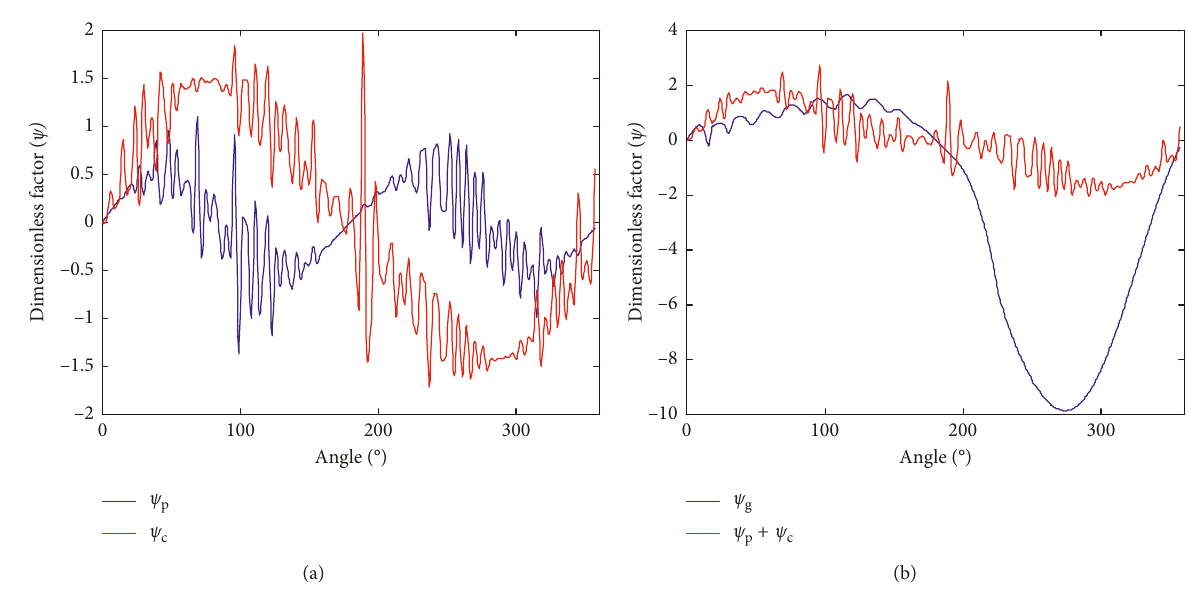
Figure 8: Inertia and gas force contributions to the piston slap with